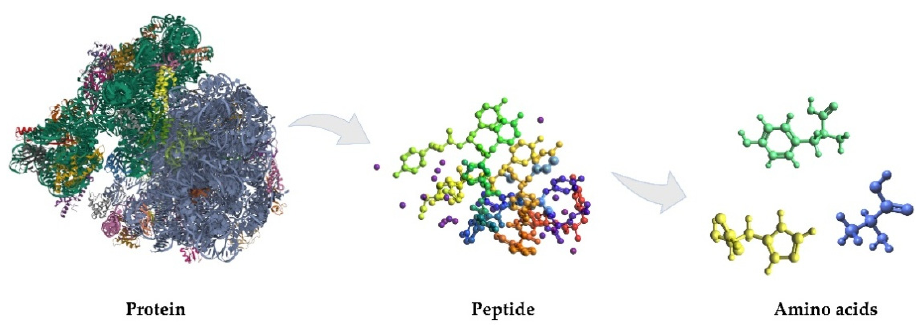
Figure 1. Structural composition of proteins and peptides.